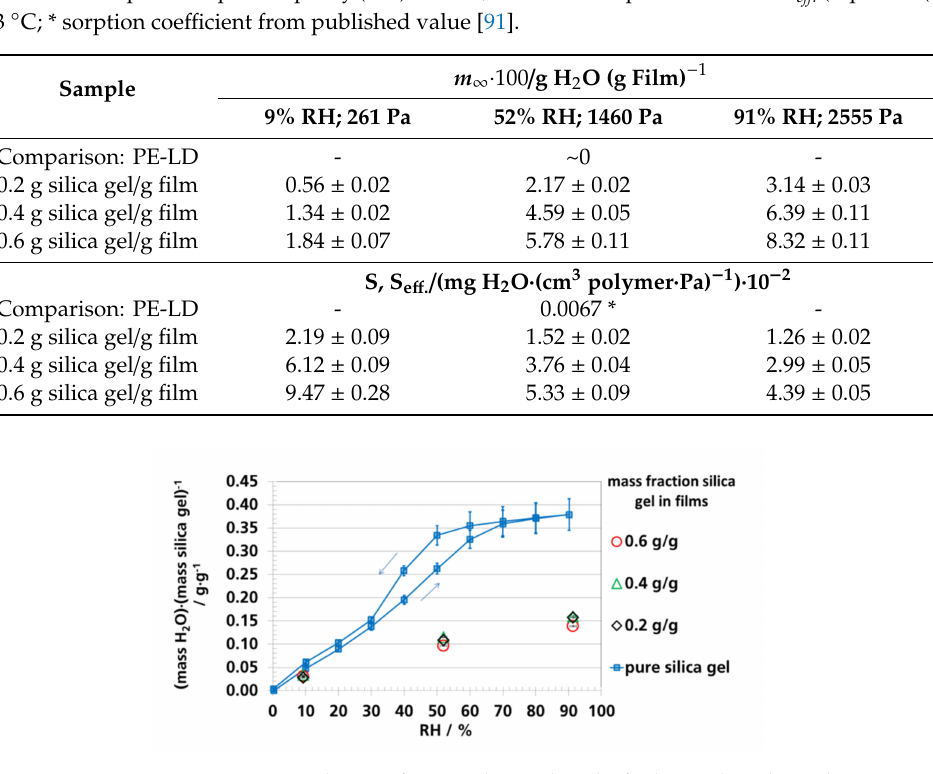
Figure 9. Water vapor sorption isotherm of pure silica gel and of silica gel in the polymer matrix (calculated from the mass fraction of silica gel in polymer and the measured absorption capacity of the films) at 23 ◦